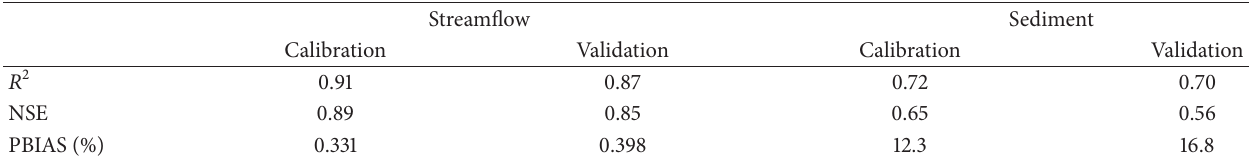
Table 4: Evaluation of model simulation during the prechange period for the catchments controlled by Laichau and Tabu stations in the DRB.